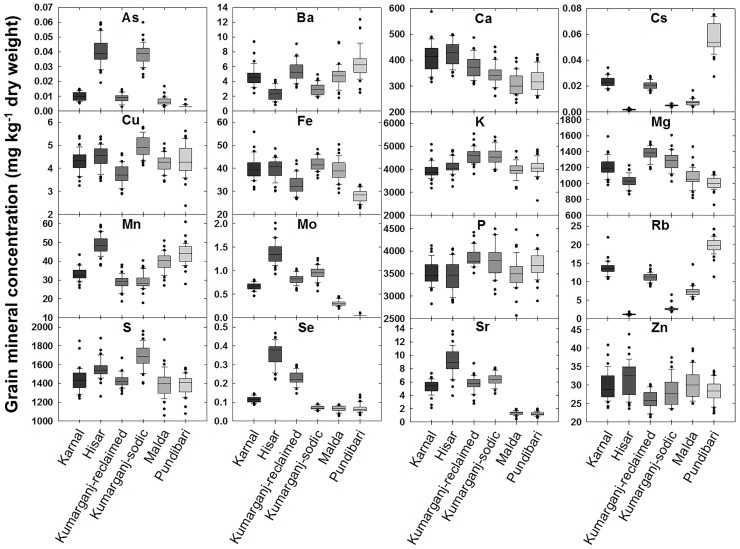
Grain element concentrations of 36 genotypes of wheat at six sites over two years.Data represent the means of two replicate plots per genotype at Karnal, Hisar, Malda and one replicate plot per genotype at Kumarganj-reclaimed and Kumarganj-sodic sites in 2013–14 and two replicate plots per genotype at all six sites in 2014–15. Boxes represent the two mid-quartiles with the median drawn; whiskers are the 95% confidence limits; circles are the outliers.